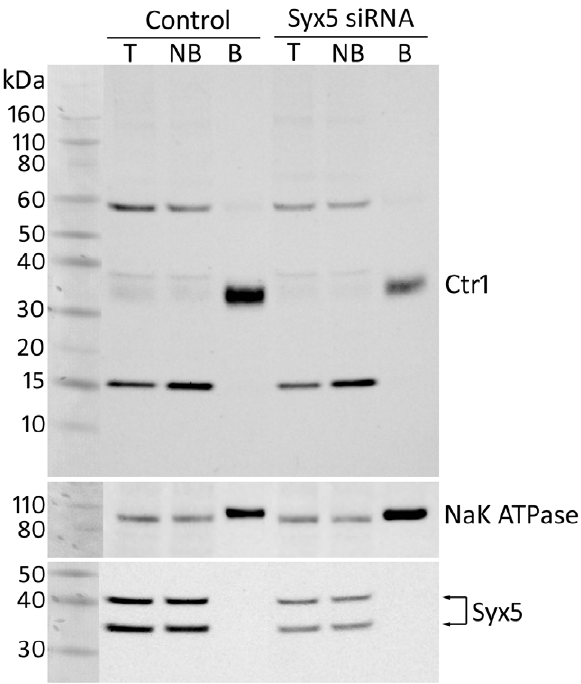
Figure 6. Syx5 suppression reduces the amount of hCtr1 at the plasma membrane of Hek293 cells. Hek293 cells stably expressing Ctr1-myc were treated with scrambled negative control or Syx5 siRNA. Cell surface proteins were isolated following biotinylation using biotin- streptavidin precipitation prior to western immuno-blotting. Ctr1was detected with an anti-c-myc antibody. Syx5 knockdown was confirmed with an anti-Syx5 antibody and anti-NaK ATPase was used as control. Total lysate (T), non-biotinylated (NB), and biotinylated (B) fractions are shown. Protein bands were quantified with densitometry. Two species of Syx5 were detected and Syx5 knockdown reduced the amount of this protein in total cell lysate to approximately 33% of control siRNA treated cells. An hCtr1 monomer of approximately 35 kDa was detected in the biotinylated fraction. Densitometric analysis of hCtr1 protein intensity relative to NaK ATPase, revealed that Syx5 knockdown reduced the about of hCtr1 at the cell surface to approximately 20% of control siRNA treated